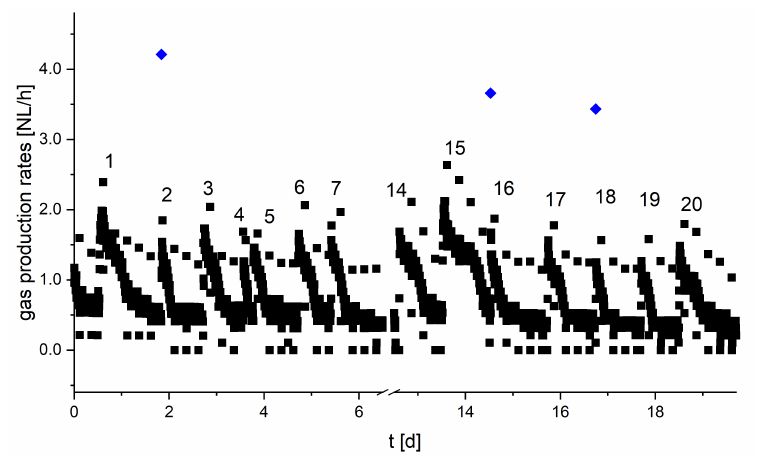
Figure 4. Gas production rates during 20 days of reactor operation. Blue dots are representing the extreme values due to the feeding. The numbers are a sequential numbering of the gas production rate curves that occur after feeding. For better visualisation feeding events 8 to 12 were